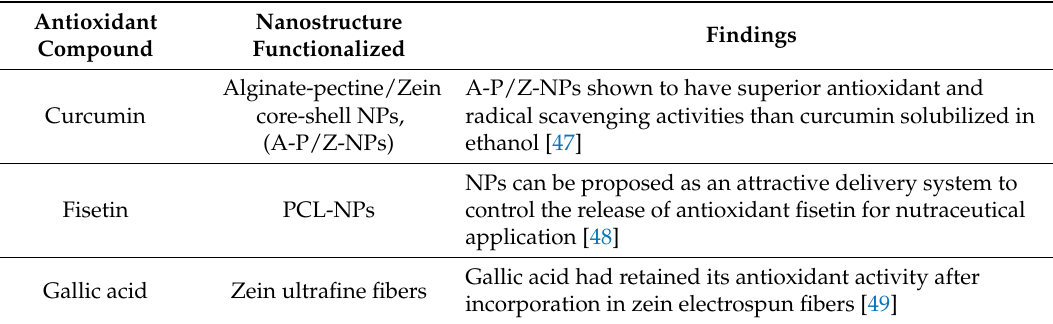
Table 1. Various antioxidants used in the functionalization of